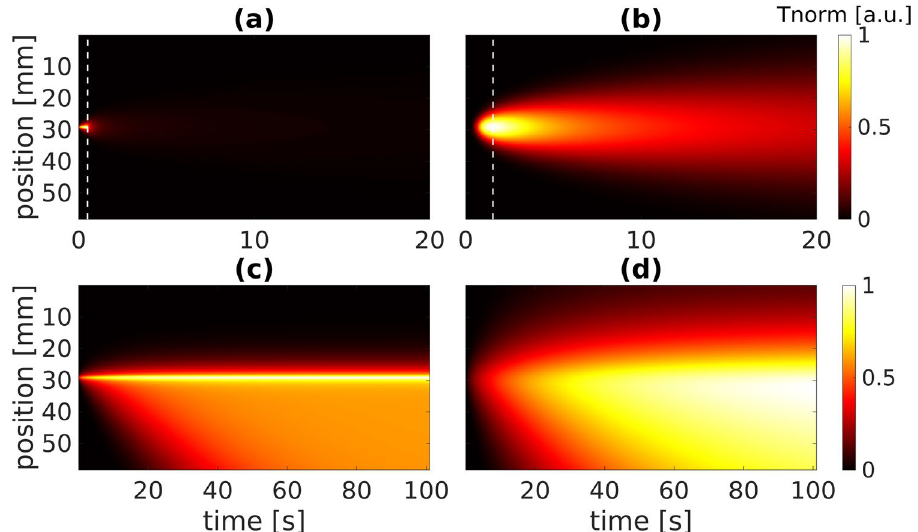
Figure 3. Diagrams of (cid:31) for ( a ) step scanning, reflection configuration, ( b ) step scanning, transmission configuration, ( c ) continuous scanning, reflection configuration, ( d ) continuous scanning, transmission configuration [ v scan = 1 mm/s in ( c , d )]. Dashed vertical lines indicate the position of the maximum thermograms used for time dimension reduction.